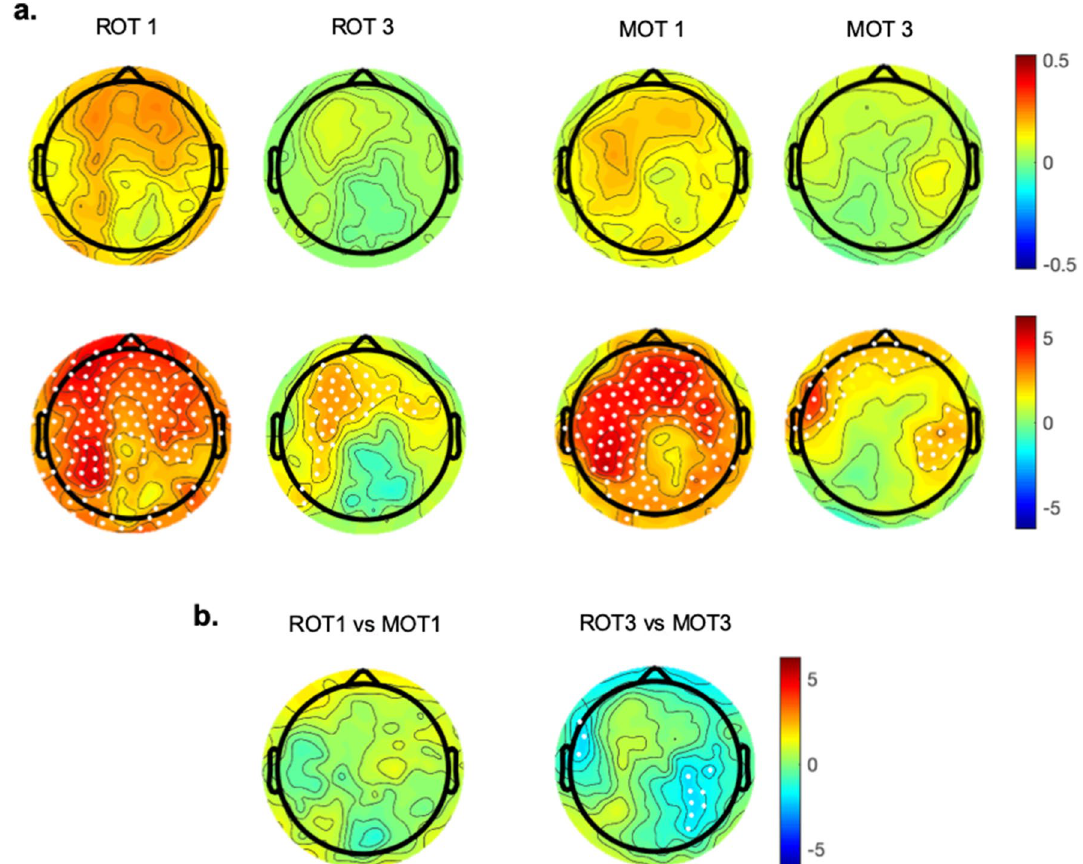
Figure 2. Within-block changes in average beta oscillatory activity in the ROT and MOT tasks. ( a ) Top. Topographic distribution of the within-block changes—computed as the difference between the last and first two zero-degree rotation sets—in the first and last blocks of ROT (ROT1 and ROT3) and MOT (MOT1 and MOT3). Bottom. Bonferroni-corrected permutation t-values maps. Dots indicate significant electrodes ( p ≤ 0.01 for Block 1; p ≤ 0.05 for Block 3). ( b ) Maps of the Bonferroni-corrected permutation t-values comparing the within-block changes of the two tasks in the first block (ROT1 vs. MOT1) and in the last block (ROT3 vs. MOT3). Significant electrodes are reported as white